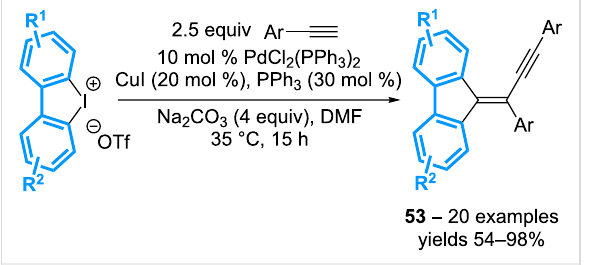
Scheme 18: Synthesis of alkyne-substituted